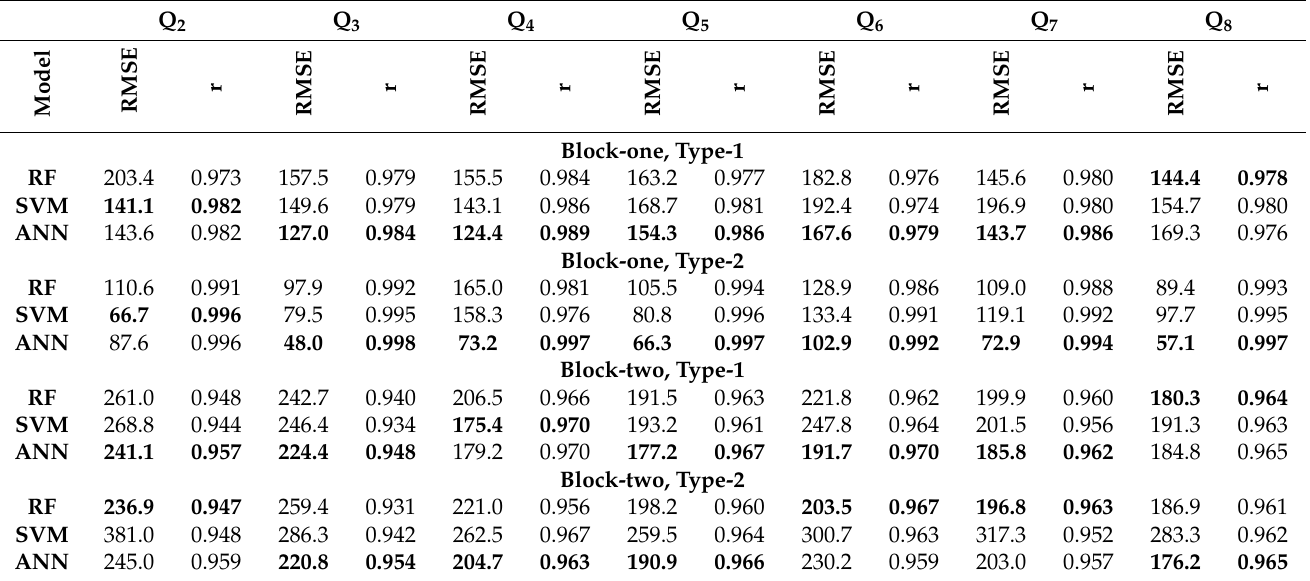
Table 4. Adjustments obtained for each selected model developed to model the MGSI (Block-one) and to predict the MGSI one month ahead (Block-two) according to each input variable’s configuration (Type). RMSE corresponds to the root mean square error and r corresponds with the correlation coefficient for each external querying station: Q 2 —Vigo-Campus (Vigo), Q 3 —Ponte Caldelas (Ponte Caldelas), Q 4 —Cabo Udra (Bueu), Q 5 —Sanxenxo (Sanxenxo), Q 6 —Porto de Vigo (Vigo), Q 7 —O Viso (Redondela) and Q 8 —Louriz á n (Pontevedra). The best results (in terms of RMSE) for each station are indicated in bold. Data from Puga-Gil (2022)